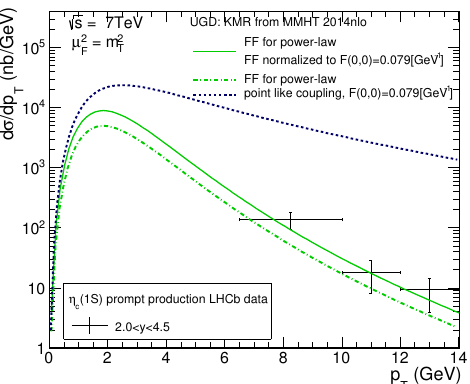
Figure 13 . Comparison of results for two di(cid:11)erent transition form factor, computed with the KMR unintegrated gluon distribution. We also show result when the ( q 2 transition form factor is neglected.